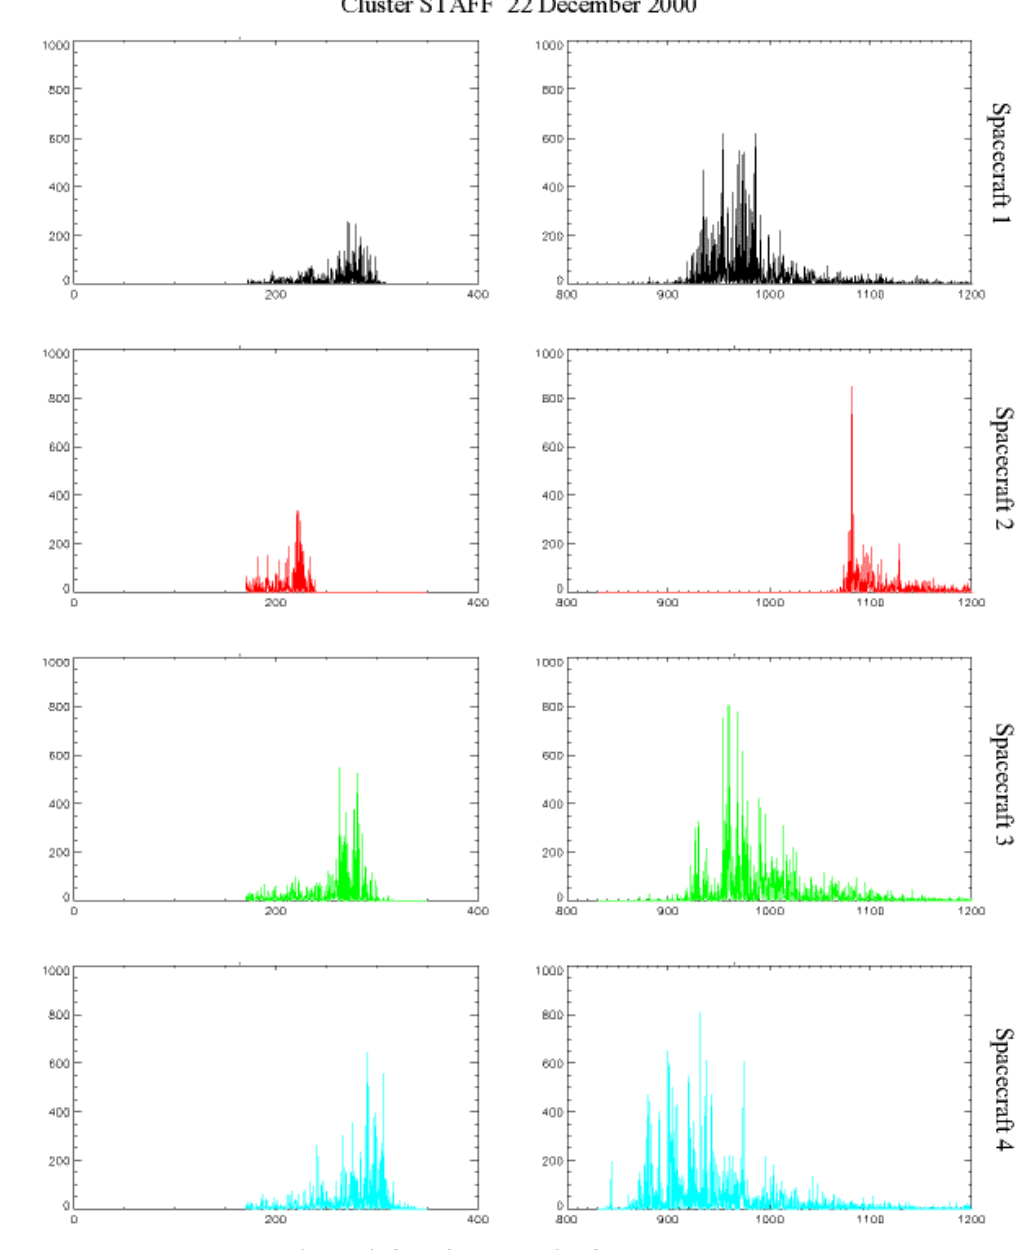
Fig. 11. Two sets of the magnetic energy of the high frequency part of the three magnetic components for the four spacecraft, in nT 2 as in the bottom panel of Fig. 10. Horizontal axes are labelled by the number of elapsed seconds since